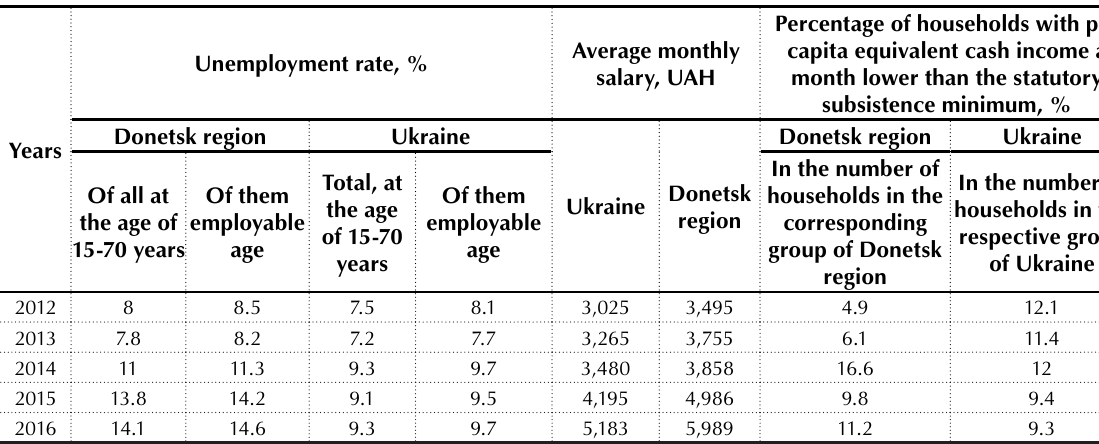
Table 3. The value of key social sector